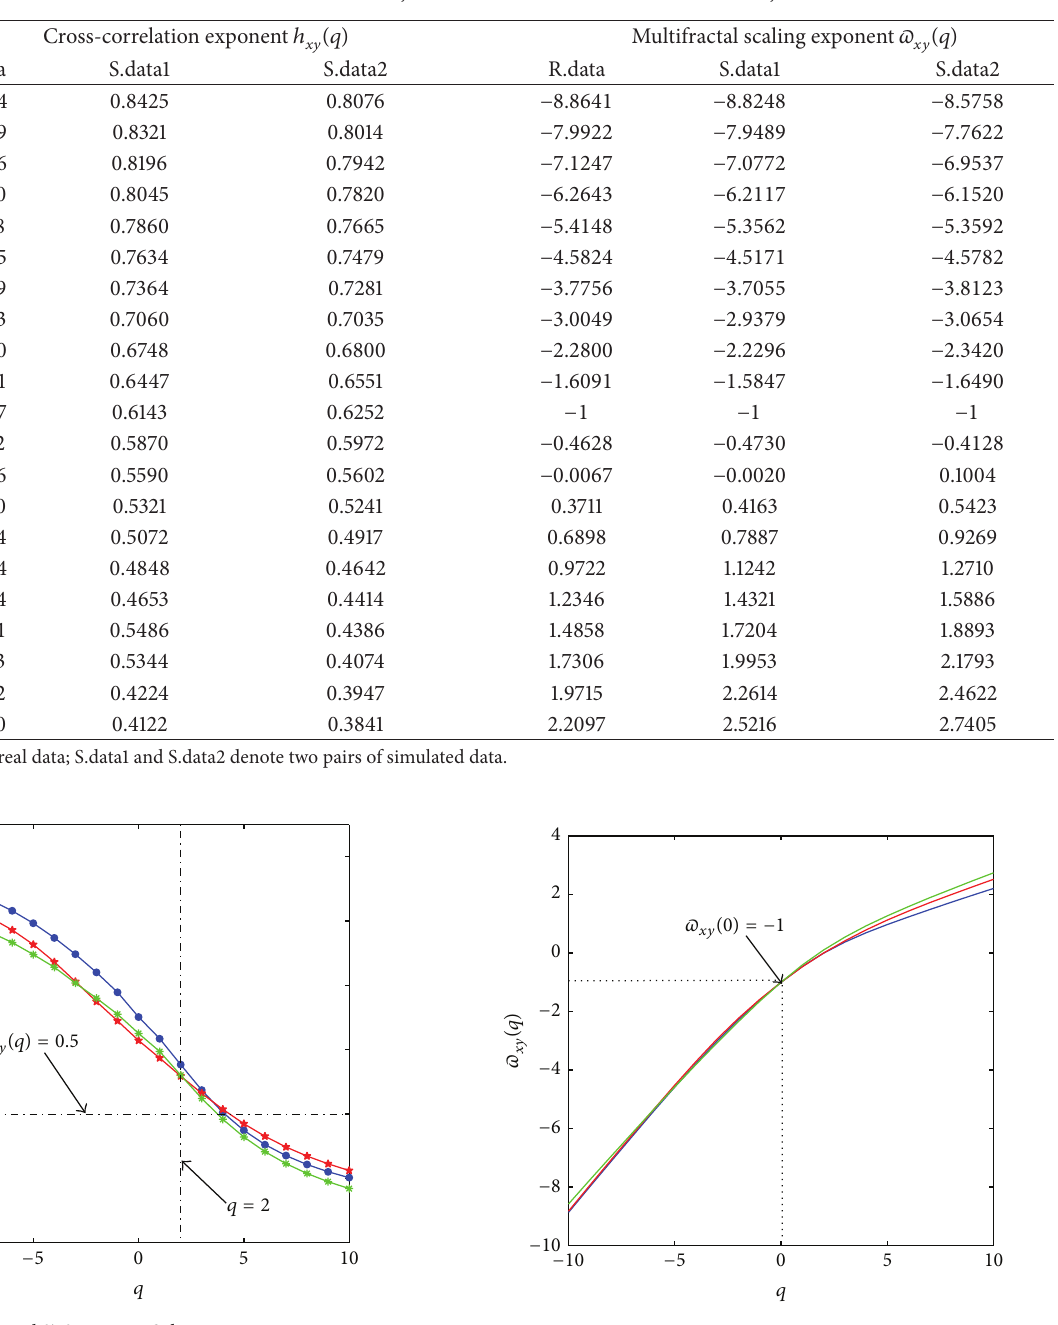
Table 2: Cross-correlation exponent ℎ 𝑥𝑦 (𝑞) and multifractal scaling exponent 𝜛 𝑥𝑦 (𝑞) .